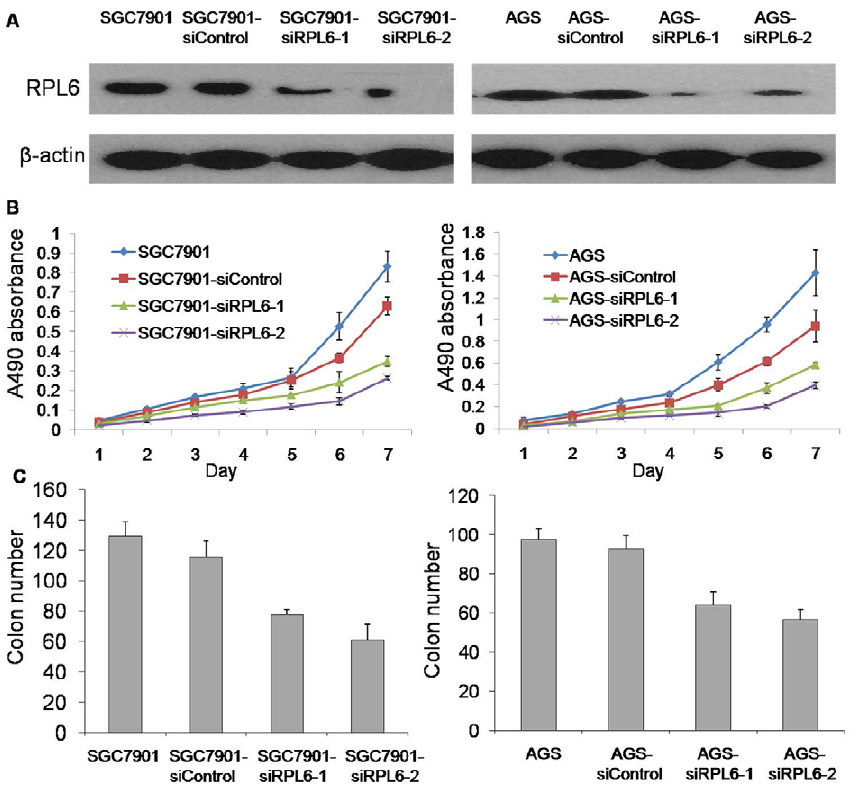
Figure 3. Downregulation of RPL6 represses gastric cancer cell growth in vitro. A. Detection of RPL6 in SGC7901/AGS, SGC7901/AGS- siRPL6-1,SGC7901/AGS-siRPL6-2, SGC7901/AGS-siRPL6-Control cells. b -actin was detected as a loading control. B. The growth curves of SGC7901/AGS cell variants with down-regulated RPL6 were determined. The proliferation of SGC7901/AGS cell derivates was monitored with MTT assay as described in ‘‘Materials and Methods’’ and their growth curves were plotted. Error bars correspond to mean 6 SD. P , 0.05 compared with control cells. C. Colony formation ability of SGC7901/AGS cell variants with down-regulated RPL6 was determined with soft agar colony formation assay as described in ‘‘Materials and Methods’’. Values represent the mean 6 SD of triplicates in each experiment. Shown are representative of at least three separate experiments. (p , 0.05).